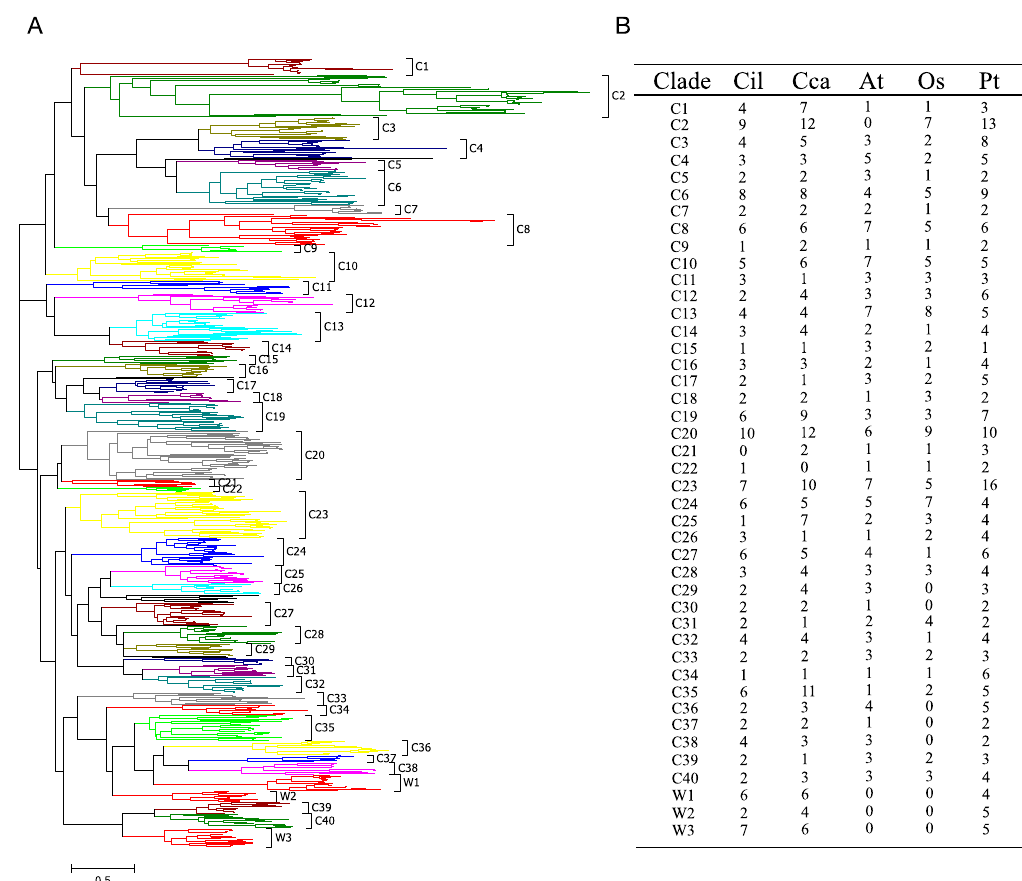
Figure 1. Phylogenetic analysis of R2R3-MYBs in five di ff erent plant species. ( A ) Phylogenetic tree of the R2R3-MYB proteins from pecan, Chinese hickory, Arabidopsis , rice and poplar. A total of 770 full-length R2R3-MYB proteins were retrieved from five plant species including Carya illinoinensis (Cil), Carya cathayensis (Cca), Arabidopsis thaliana (At), Oryza sativa (Os), and Populus trichocarpa (Pt). R2R3-MYB proteins from five species were divided into 43 clades (C1 to C40 and W1 to W3). ( B ) The number of R2R3-MYB proteins in each clade in di ff erent species. Detailed information of this phylogenetic tree is provided in Figure S1.